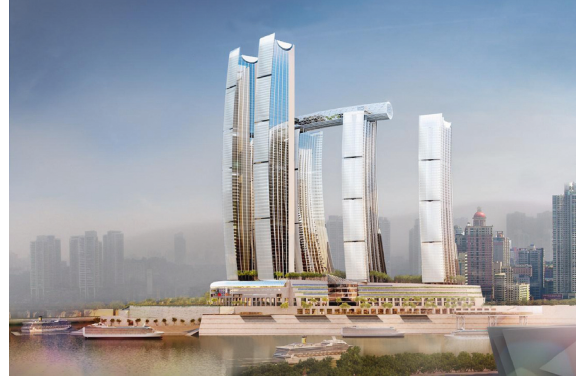
Figure 1: Perspective view of the buildings.